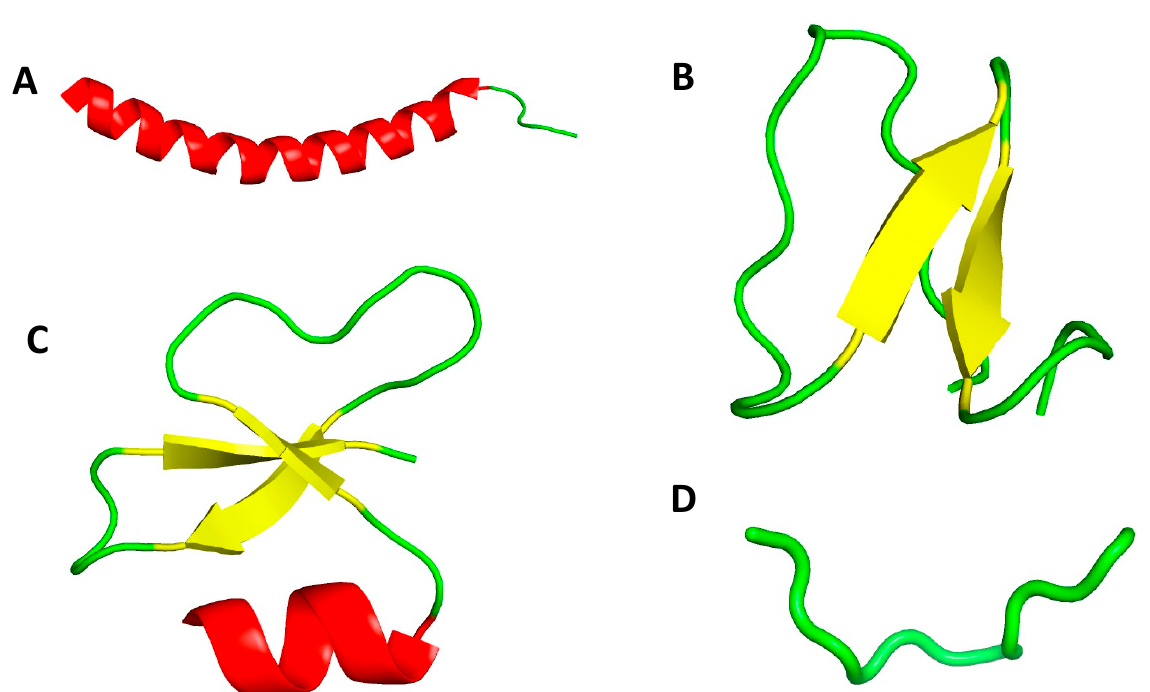
Figure 4. Three-dimensional (3D) structures of representative antimicrobial peptides. ( A ) α -helical Scheme 37. (PDB code: 2K6O); ( B ) β -sheet structure of plant kalata B1 (PDB code: 1NB1); ( C ) αβ structure of human β -defensin-1 HBD-1 (PDB code: 1IJV); ( D ) non- αβ structure of cattle indolicidin (PDB code: 1G89).